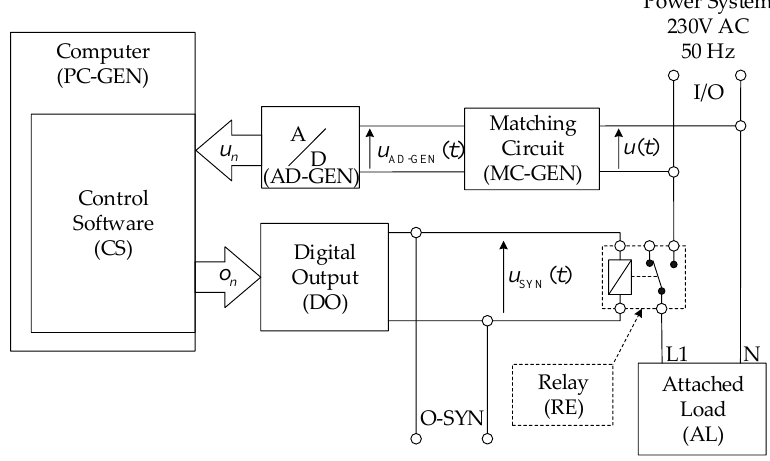
Figure 3. Block diagram of the pulse signal generator.